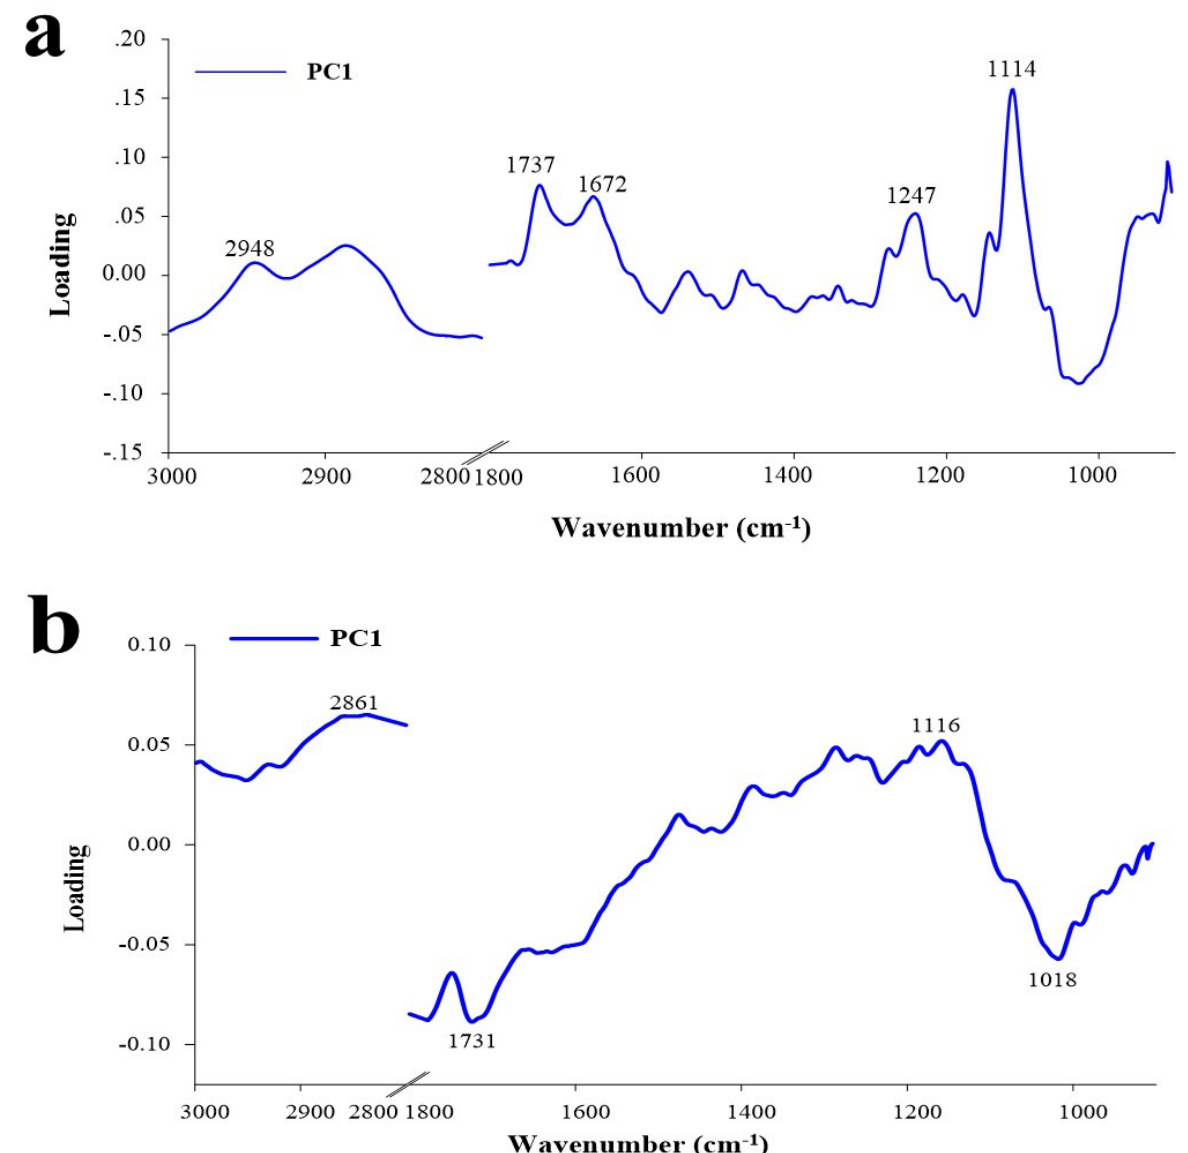
Figure 7. PC1 and PC2 loading plots from PCA analysis on the range of 1800–900 cm − 1 of the mesophyll and epidermis of rice leaves of cv. KDML 105 in an inoculation challenge with Xoo at 14 DAI under greenhouse conditions. ( a ) Mesophyll of rice plant leaves. ( b ) Epidermis of rice plant leaves.